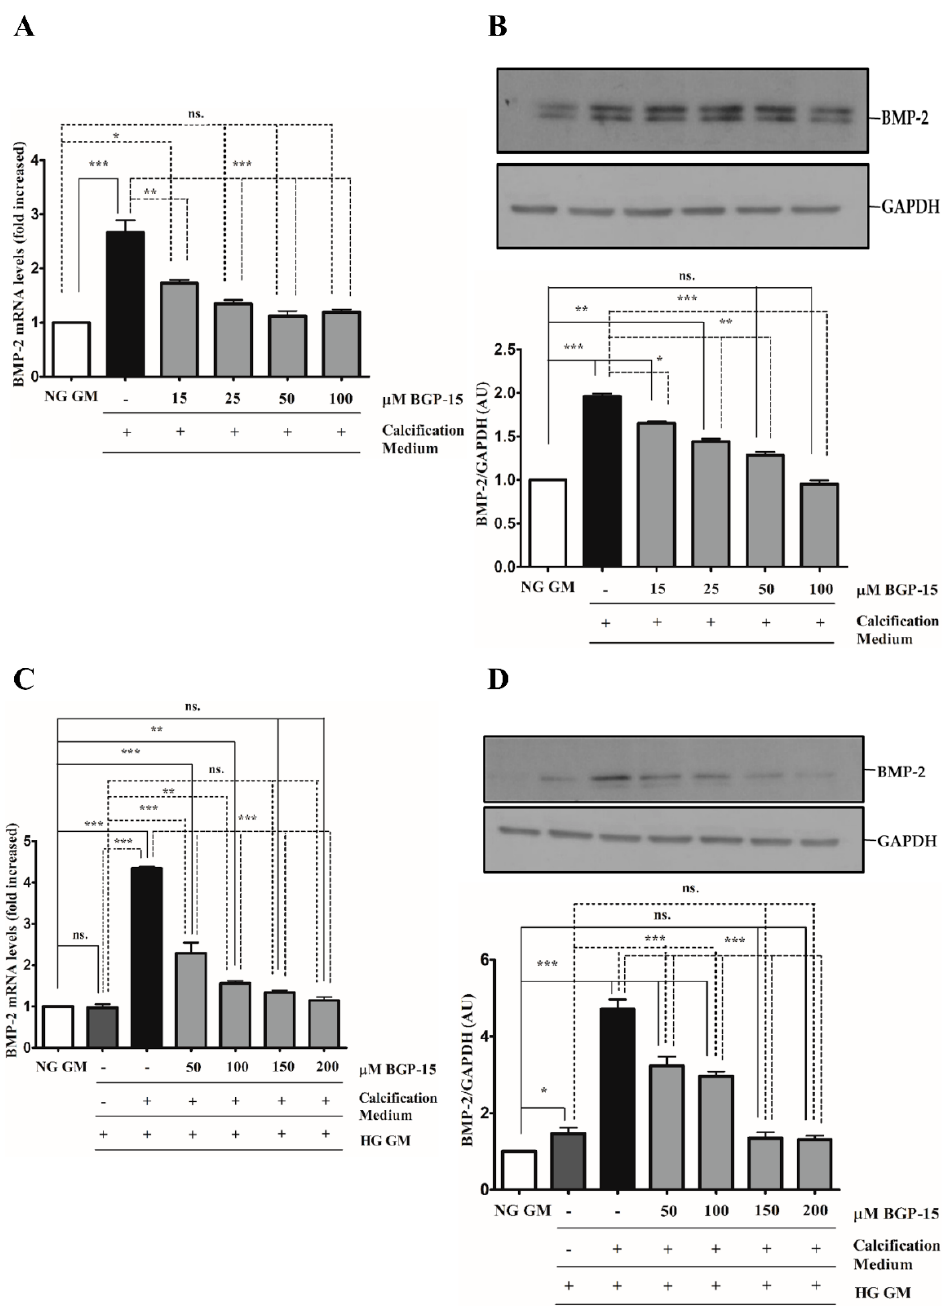
Figure 7. BGP-15 decreases BMP-2 expression induced by high Pi in NG and HG conditions. VSMCs were treated as in Figure 2. Expression of BMP-2 was analyzed by RT-qPCR and immunoblot ( A – D ). Relative expression of BMP-2 mRNA ( A ) and protein ( B ) in both NG and HG conditions (( C ): mRNA; ( D ): protein) is shown as mean ± SEM of three independent experiments. Relative mRNA expression was normalized to RNA45S5, while protein expression to GAPDH. Statistical analysis was performed by the one-way ANOVA test followed by Bonferroni correction. A value of p < 0.05 was considered significant. * p < 0.05, ** p < 0.01, *** p <